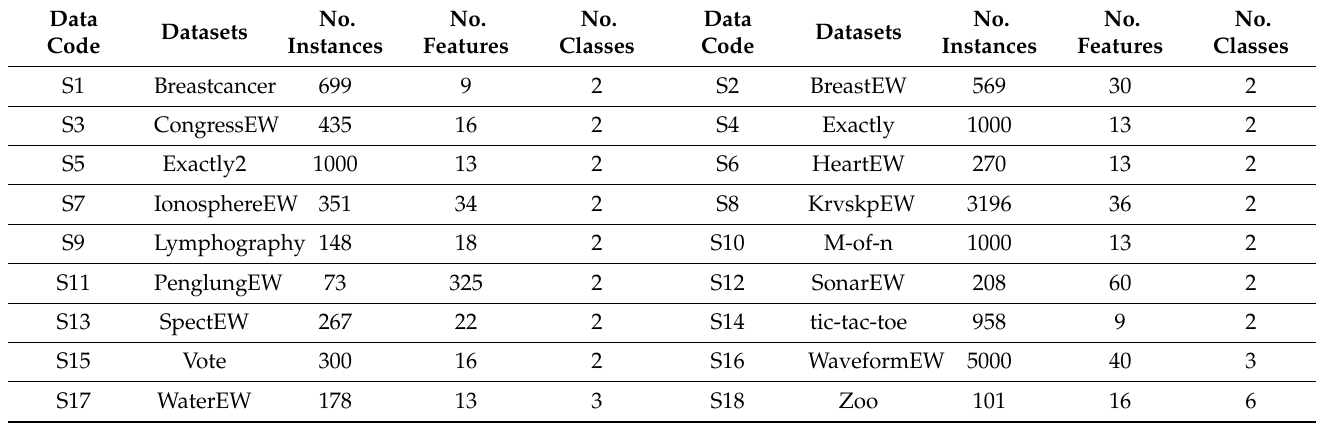
Table 2. Description of datasets.